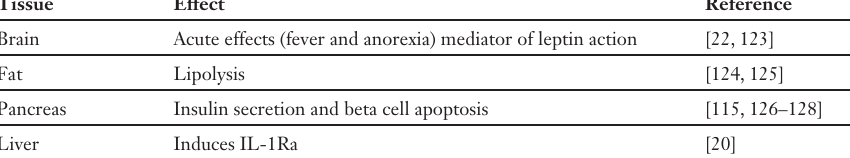
Table 2 The il-1 system has important roles in the brain and